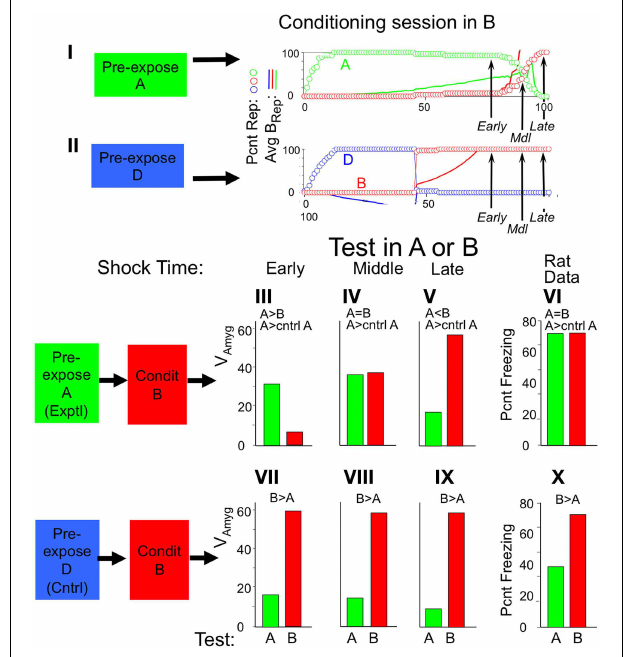
FIGURE 11 | Conditioning in a novel context when a similar context is familiar. Context A and B are 95% similar; context D is maximally different from both (50% similar). (I,II) . Sessions in context B after pre-exposure to either context A or D. Arrows ( Early, Middle, Late ) indicate when USs were given during each type of conditioning session. Circles plot percentage of runs in which the specified representation was active, and lines the mean weight of evidence for the representation (same color coding). (III–X) Average fear levels in contexts A (green bars) and B (red bars) after conditioning in B following pre-exposure to either context A or D. First 3 graphs in each row are simulation results for test following conditioning with USs at the early, middle, or late time points. Pre-exposures were always 60 samples; conditioning sessions were 75 ( Early ), 88 ( Middle ) or 95 ( Late ) sample long with US at end. All figures are averages for 30 simulations. (VI,X) . Far-right graphs are Rudy and O’Reilly data (Rudy and O’Reilly,